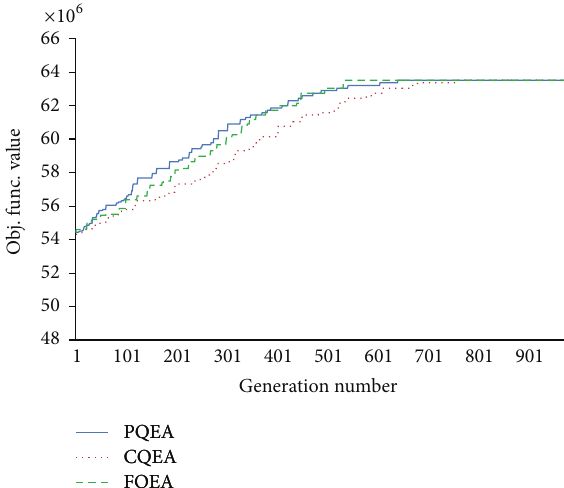
Figure 10: Convergence graph of PQEA, CQEA, and FQEA on COUNTSAT problem size, 𝑛 , being 400.